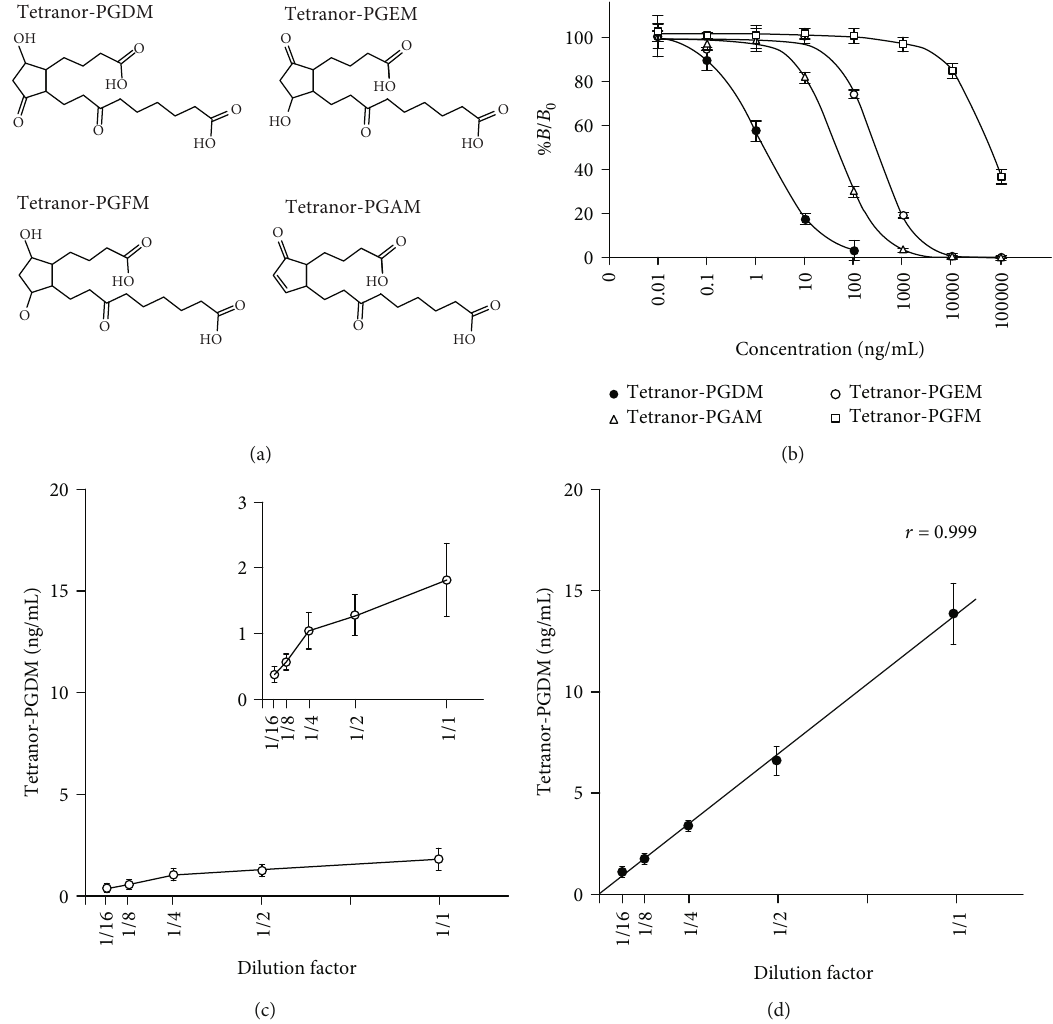
Figure 2: Analysis of tetranor-PGDM in urine. (a) Lipids for cross-reactivity test of tetranor-PGDM. (b) Inhibition curves for tetranor- PGDM, tetranor-PGEM, tetranor-PGAM, and tetranor-PGFM. Linearity of dilution curves for arti fi cial urine samples before (c) and after (d) solid-phase extraction. The arti fi cial urine sample with a high tetranor-PGDM level was diluted stepwise with the assay solution. Table 2: Analytical recovery of tetranor-PGDM in arti fi cial urine samples with di ff erent tetranor-PGDM concentrations. Concentration (ng/mL) Mean recoveries (%) Sample Spiked Theoretical Measured 0 — AU-1 ( n = 3 ) — 5.95 —